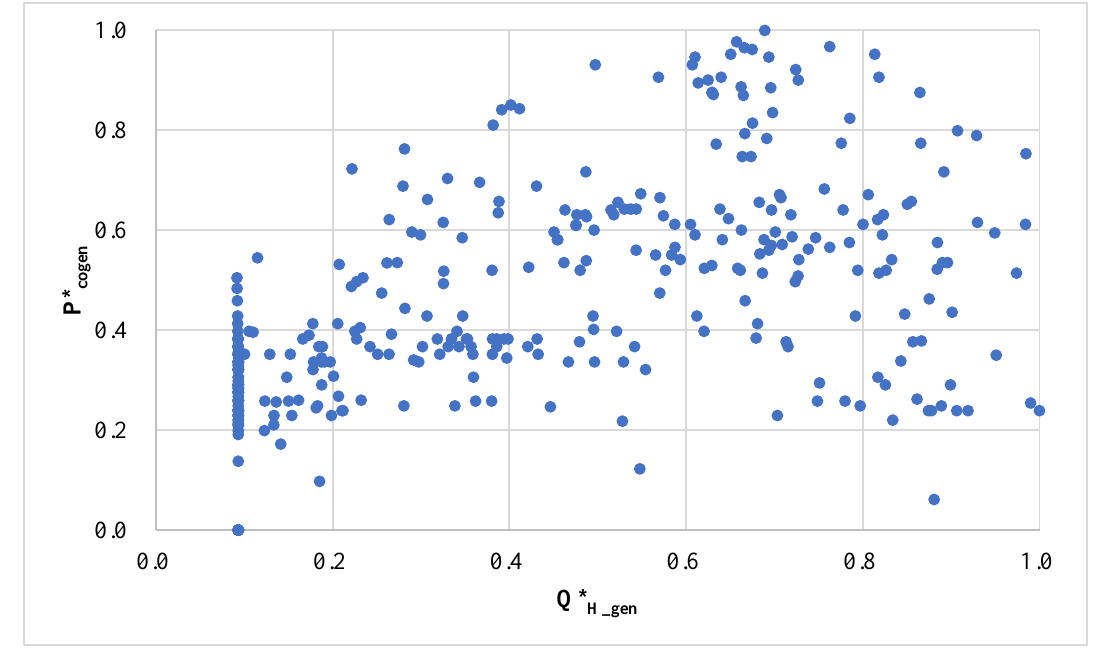
Figure 15. Relationship between the key operational parameters for annual operation events in Case D.